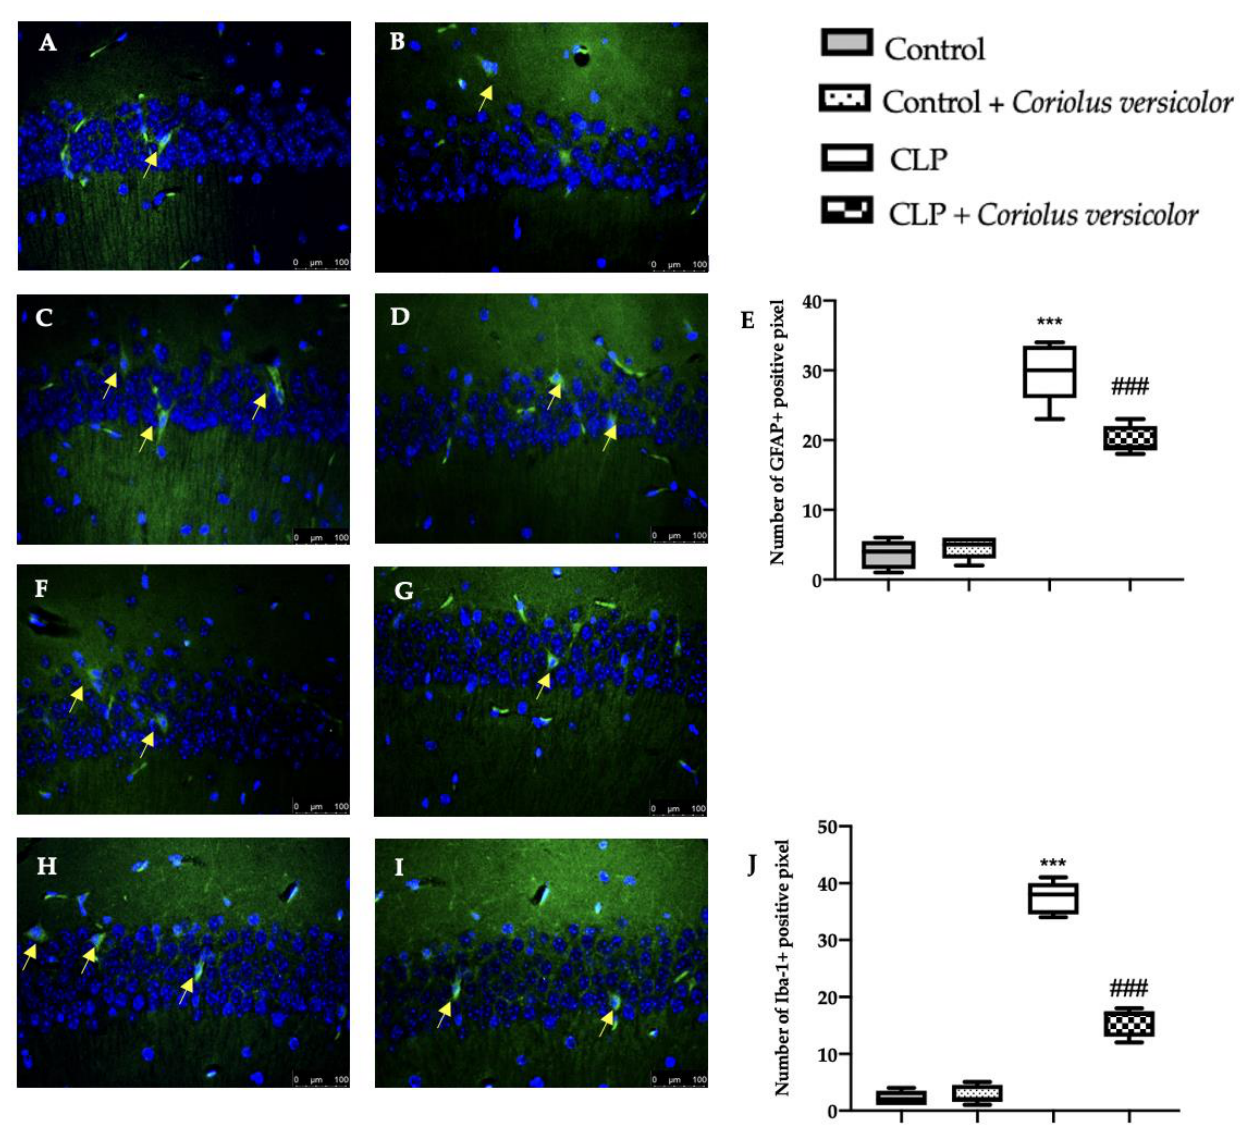
Figure 7. Coriolus versicolor reduced glia activation in hippocampus induced by CLP 28 days after surgery. Immunofluorescence analysis of glial fibrillary acidic protein (GFAP): Control ( A ), Control + Coriolus versicolor ( B ), CLP ( C ), CLP + Coriolus versicolor ( D ), graphical quantification of GFAP expression ( E ); immunofluorescence analysis of Ionized calcium-binding adapter molecule1 (Iba-1): Control ( F ), Control + Coriolus versicolor ( G ), CLP ( H ), CLP + Coriolus versicolor ( I ), graphical quantification of Iba-1 expression ( J ). *** p < 0.001 vs. control, ### p < 0.001 vs. CLP.